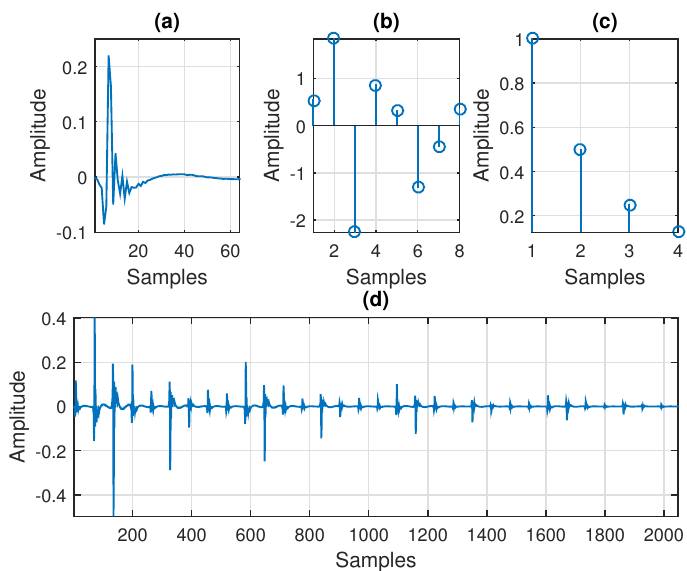
Figure 2. The components of the third-order system used in simulations: ( a ) h 1 is the first impulse response (of length L 1 = 64) from the G168 Recommendation [26]; ( b ) h 2 is a randomly generated impulse response (of length L 2 = 8), with Gaussian distribution; ( c ) the impulse response h 3 (of length = 0.5 l 3 − 1 , with l = 1,2, . . . , L L 3 = 4), with the coefficients computed as h 3, l 3 3 ; and ( d ) the global 3 impulse response (of length L = L 1 L 2 L 3 = 2048) results based on (17), h = h 3 ⊗ h 2 ⊗ h 1